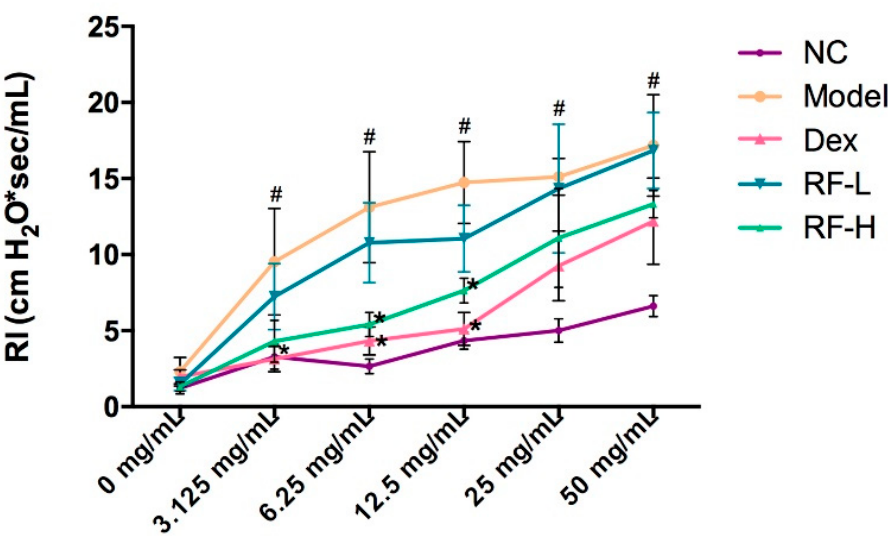
Figure 4. At 24 h after the last challenge, the inspiratory resistance (RI) was measured at the challenge of MCh. Normal control, saline-induced mice only. Model, OVA-induced mice. Dex, OVA-induced mice treated with Dex (1.0 mg/kg). RF-H, OVA-induced mice treated with Renifolin F (3.0 mg/kg). RF-L, OVA-induced mice treated with Renifolin F (1.5 mg/kg). Statistics represented as the mean ± SEM ( n = 6). # p < 0.05 vs. Normal control, and * p < 0.05 vs. Model.